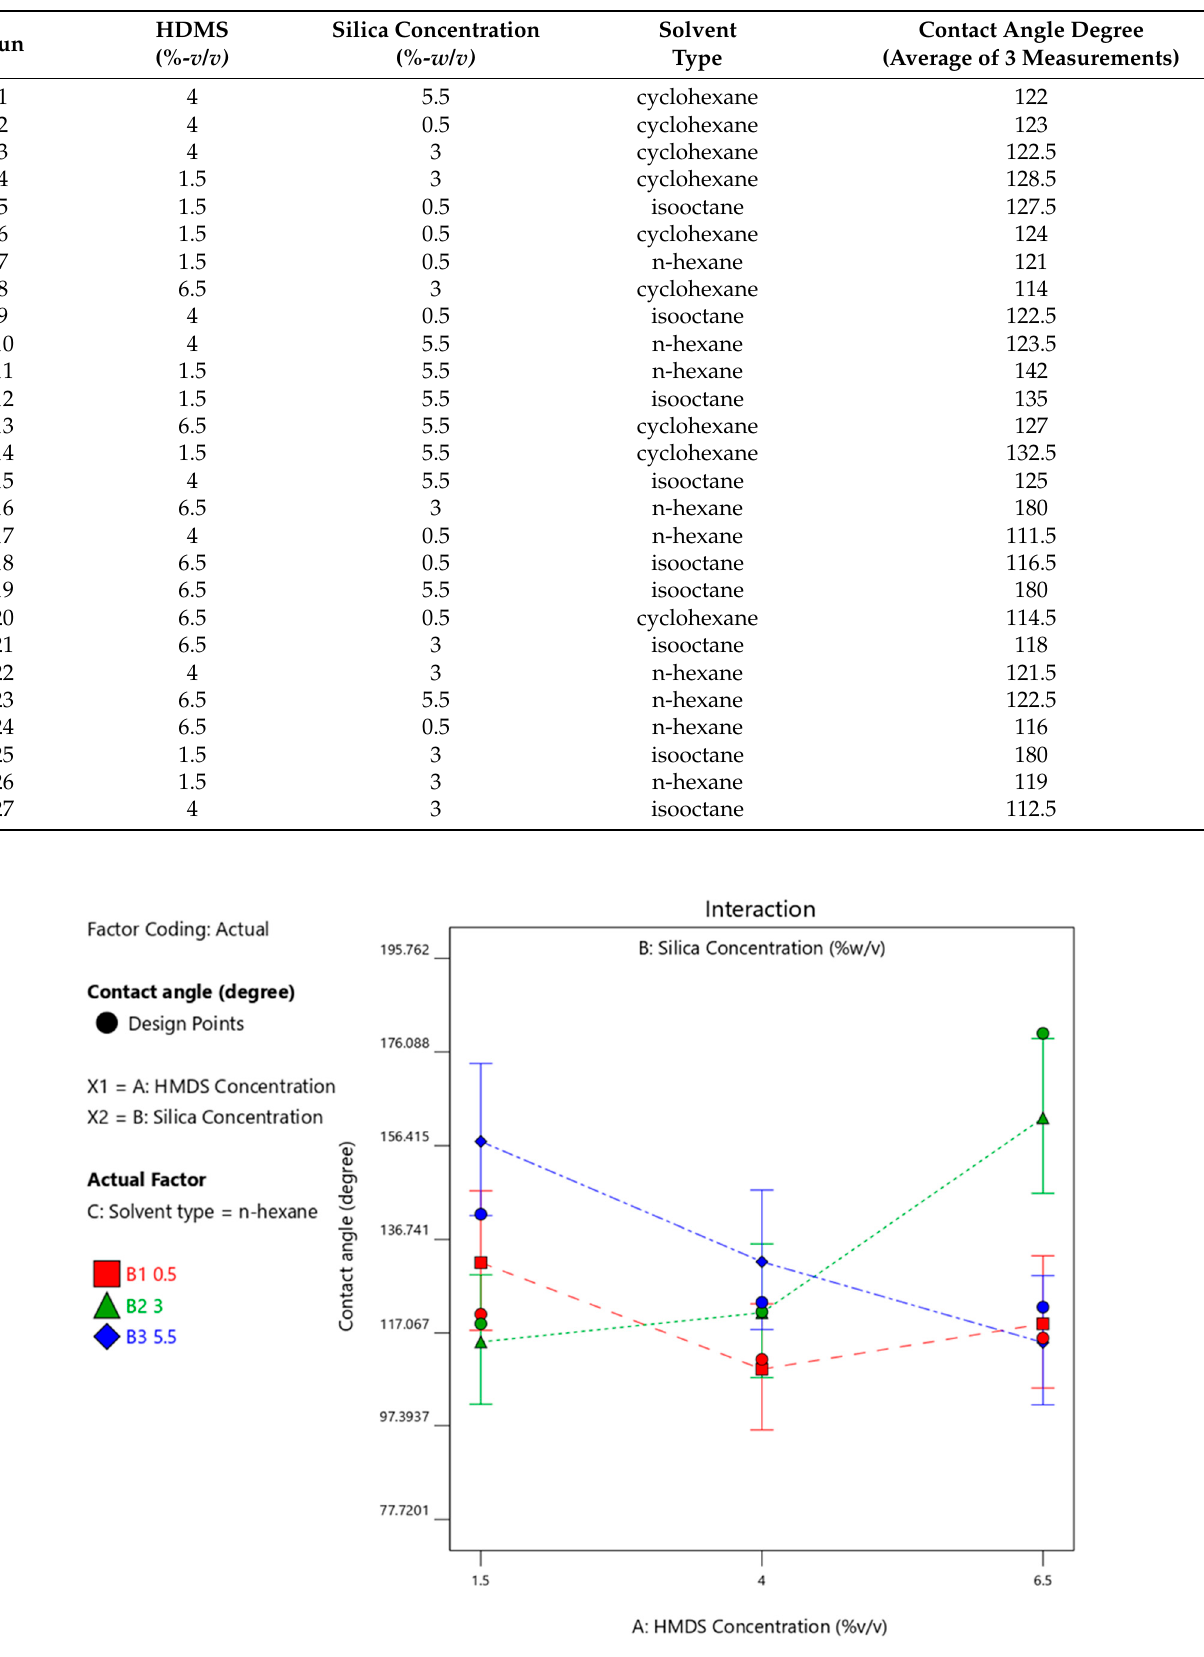
Figure 4. Contact angle response upon interaction between HMDS and silica concentration with n-hexane solvent.